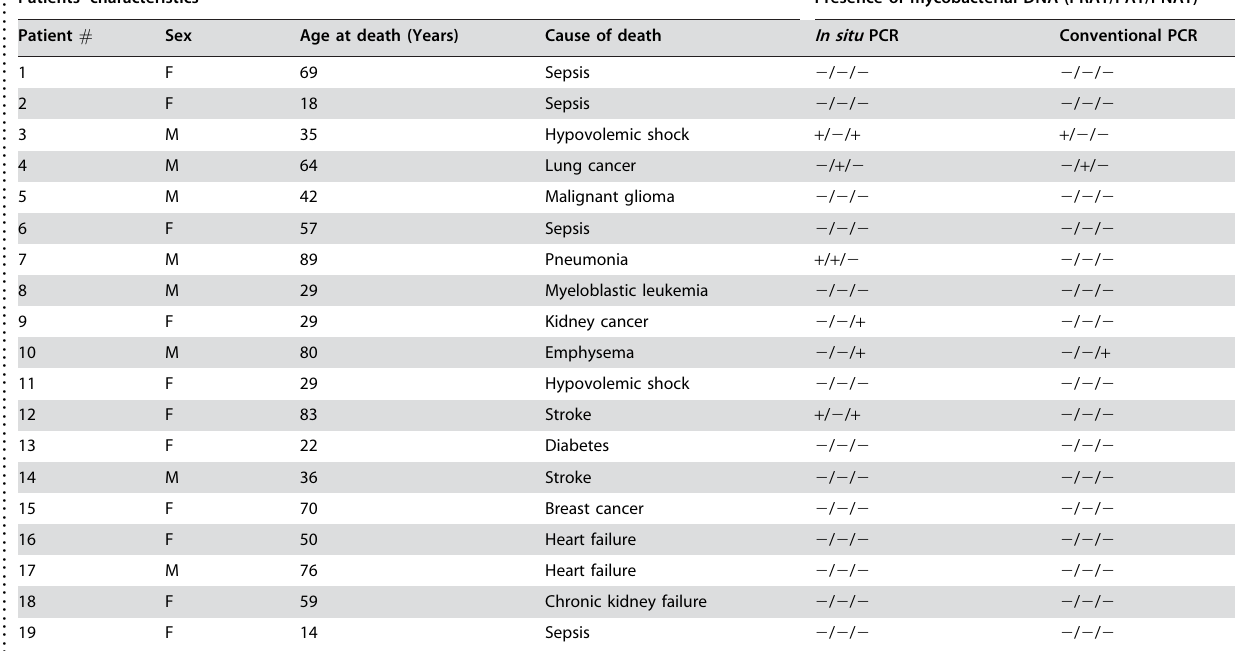
Table 1. Detection of M. tuberculosis DNA in adipose tissue from Mexican autopsy samples a .. ... .... ... ... .... ... ... .... ... ... .... ... ... .... ... ... .... ... ... .... ... ... .... ... ... .... ... ... .... ... ... .... ... ... .... ... ... .... ... ... .... ... ... . Patients’